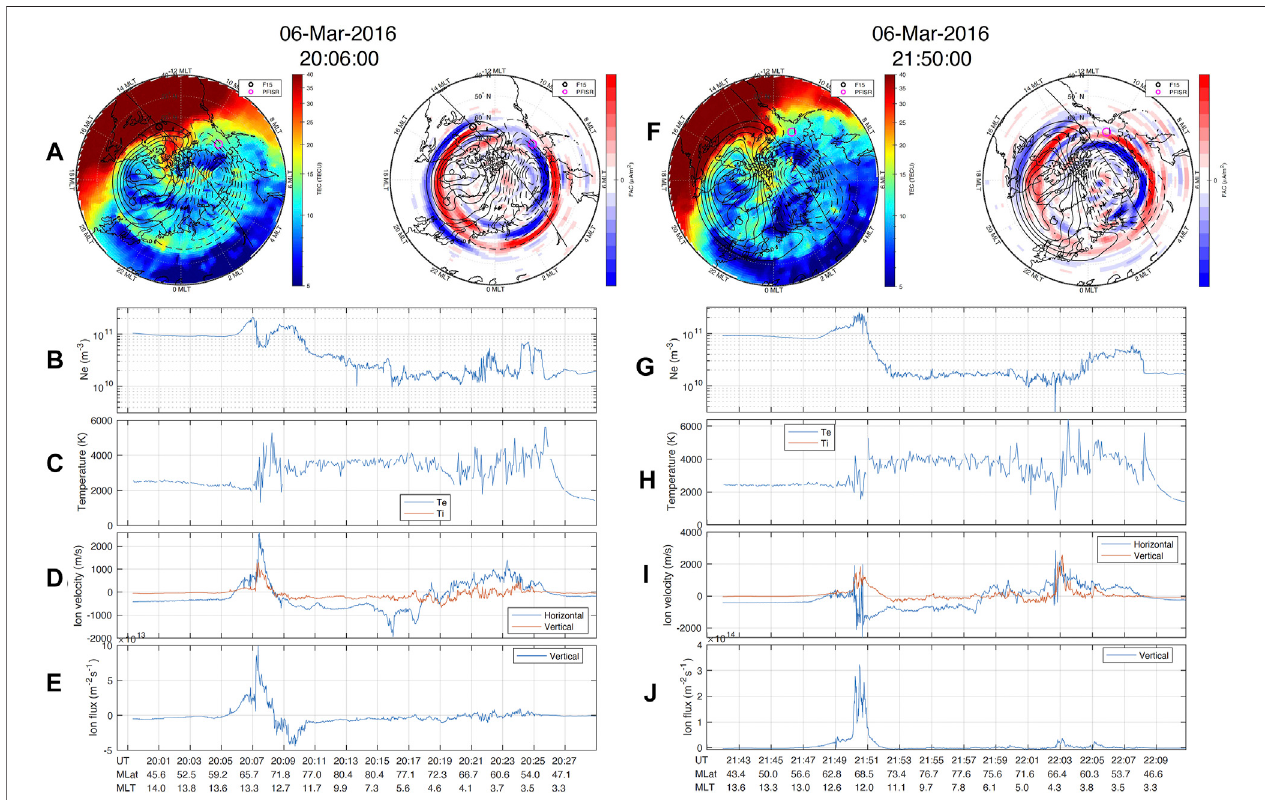
FIGURE 7 | The same format as Figure 6 but near the peak of the storm